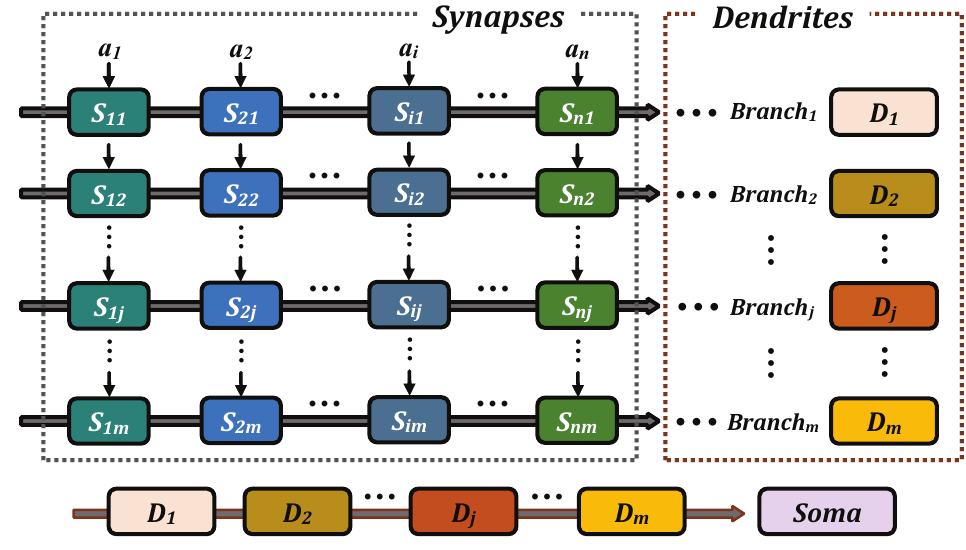
Figure 1. Architectural description of the